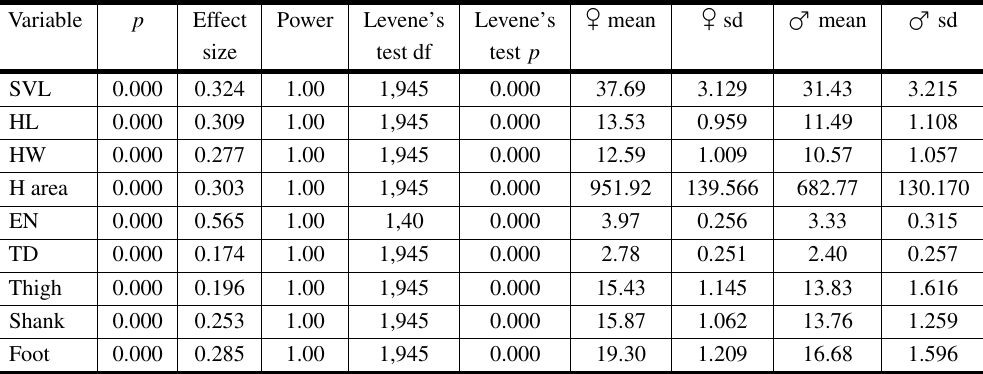
Comparison of ANOVA and ANCOVA analyses on raw and transformed data for Leptodactylus podicipi- nus , N = 528 females, 419 males for all variables except EN, N = 21 females and